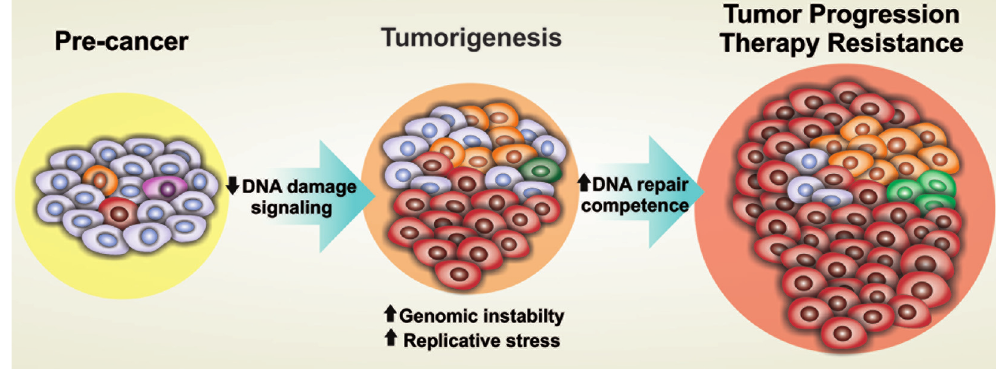
Figure 1 - DNA damage signaling and repair pathways show opposite regulation in tumorigenesis and tumor progression. Early in tumorigenesis, onco- geneactivationleadstoreplicationstressandDNAdamage,usuallytriggeringtheDDRmachineryandleadingtocheckpoint-imposedsenescenceorcell death. When this barrier is overcome, by loss-of-function mutations in DDR and/or DNA repair genes, tumor establishment ensues. Progressively ad- vanced tumors experience increasing levels of replication stress and genetic instability and often adapt to this environment, developing exacerbated DNA repair competences that avoid cell death and favor tumor